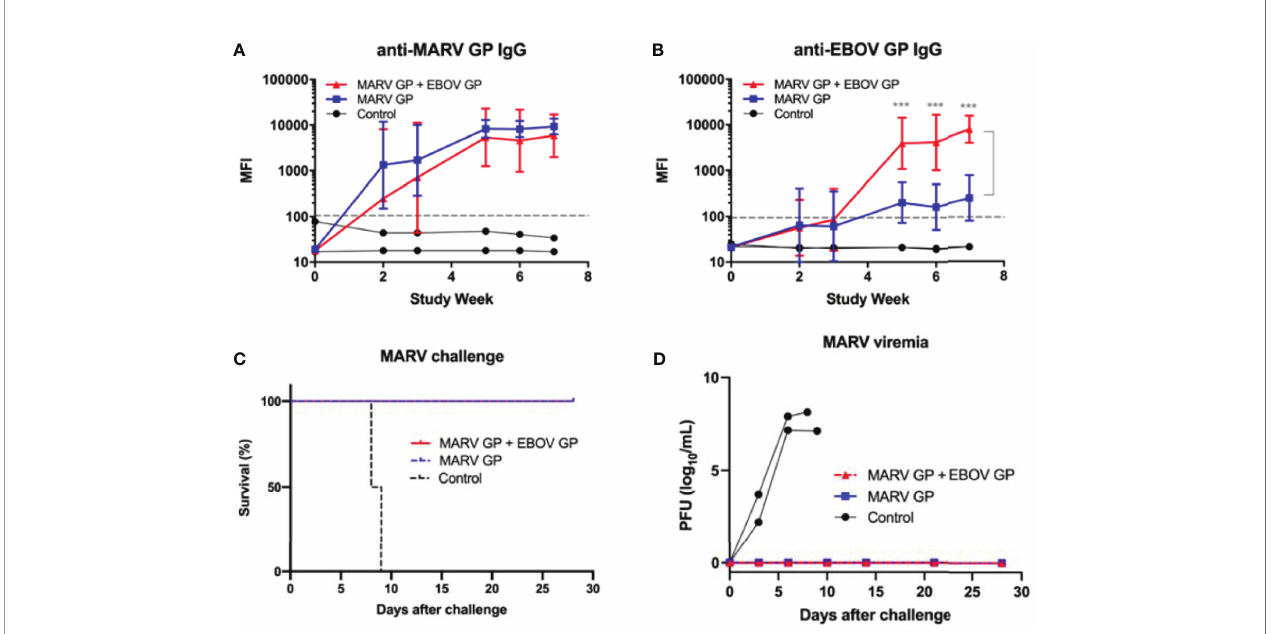
FIGURE 6 | Immune response to MARV vaccination, survival and viremia after MARV challenge. MIA performed in triplicate for animals vaccinated at three-week intervals with three doses of MARV GP with adjuvant (n=4) or MARV GP + EBOV GP with adjuvant (n=4). Controls received adjuvant only (n=2): (A) MARV GP- binding IgG and (B) EBOV GP-binding IgG. Each data point for vaccinated groups represents geometric mean ± 95% con fi dence interval whereas data points for controls were plotted per individual animal. The dashed grey line marks the threshold for positive detection of antigen-speci fi c IgG at 3 SD above mean MFI of negative control samples. (C) Kaplan-Meier survival curves after challenge with MARV. (D) MARV viremia as assessed by plaque assay. Each data point for vaccinated groups represents mean ± SEM. Data points for controls were plotted per individual animal. ***p <